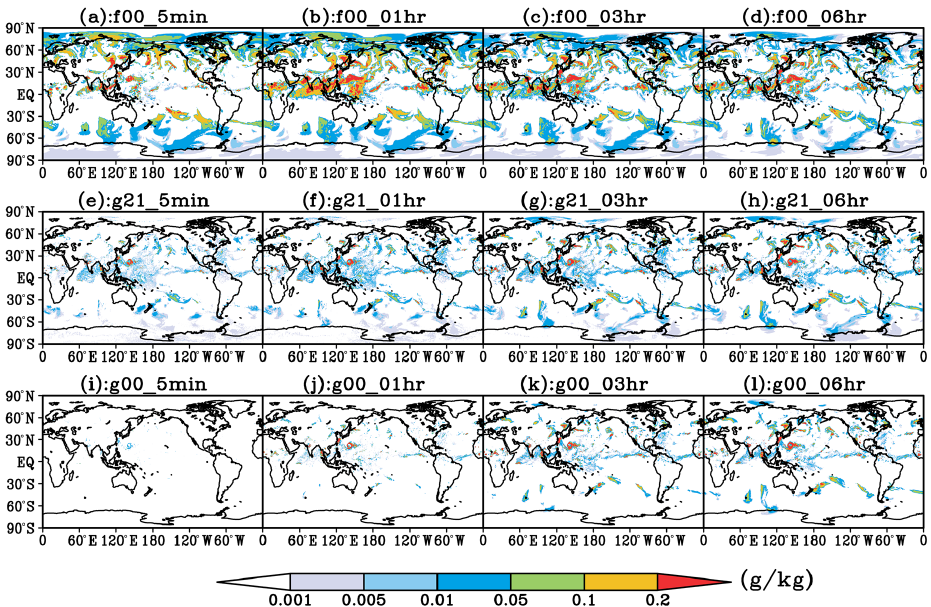
Figure 5. Distributions of all hydrometeor content at 400hPa at different forecast times (5min, 1, 3, 6h) simulated by F00 (a–d) , G21 (e–h) , and G00 (i–l) experiments, respectively (values given in gkg − 1